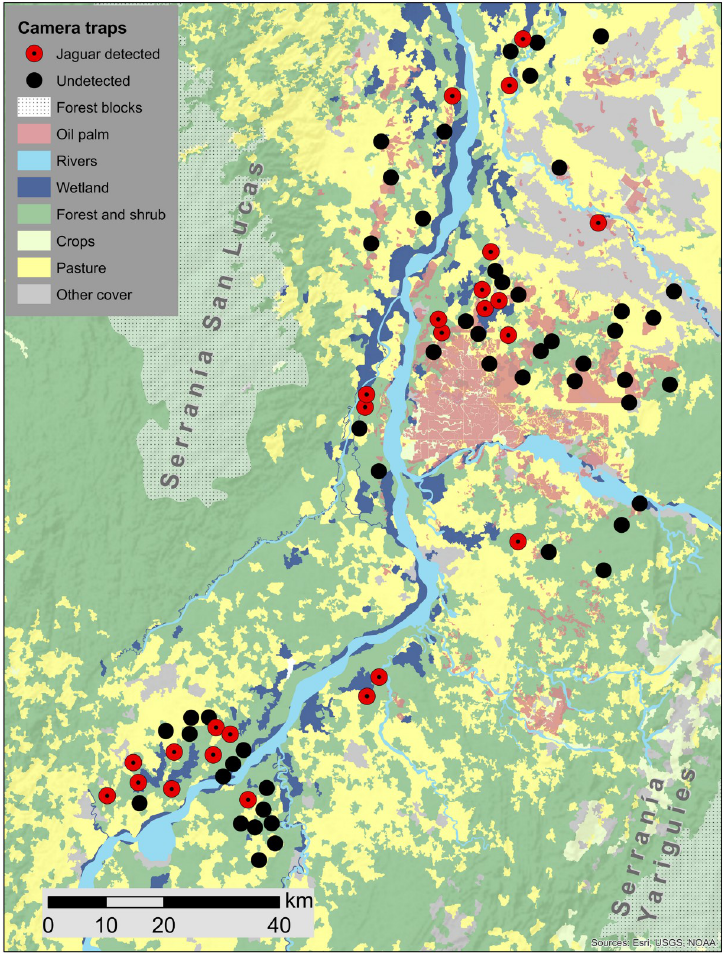
Fig 2. Study area. Land cover and camera trap locations, including sites of jaguar detections in the middle Magdalena River valley, Colombia.